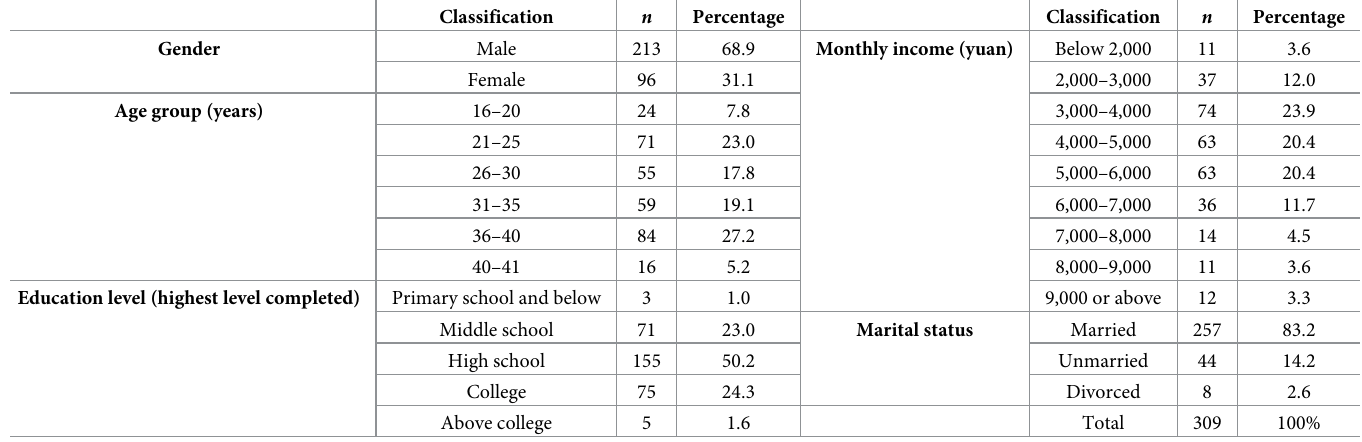
Table 1. Sample characteristics (N = 309)